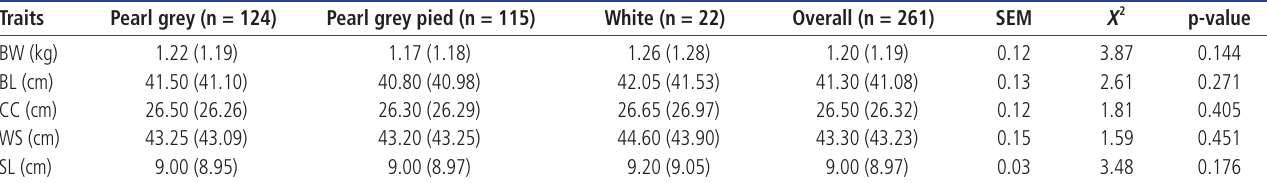
SEM, standard error of the mean; BW, body weight; BL, body length; CC, chest circumference; WS, wingspan; SL, shank length. 1) Light grey (n = 4), brown (n = 5), bronze (n = 1), and light blue (n = 2) were excluded due to small number of observations. Comparison of mean ranks by Kruskal-Wallis H